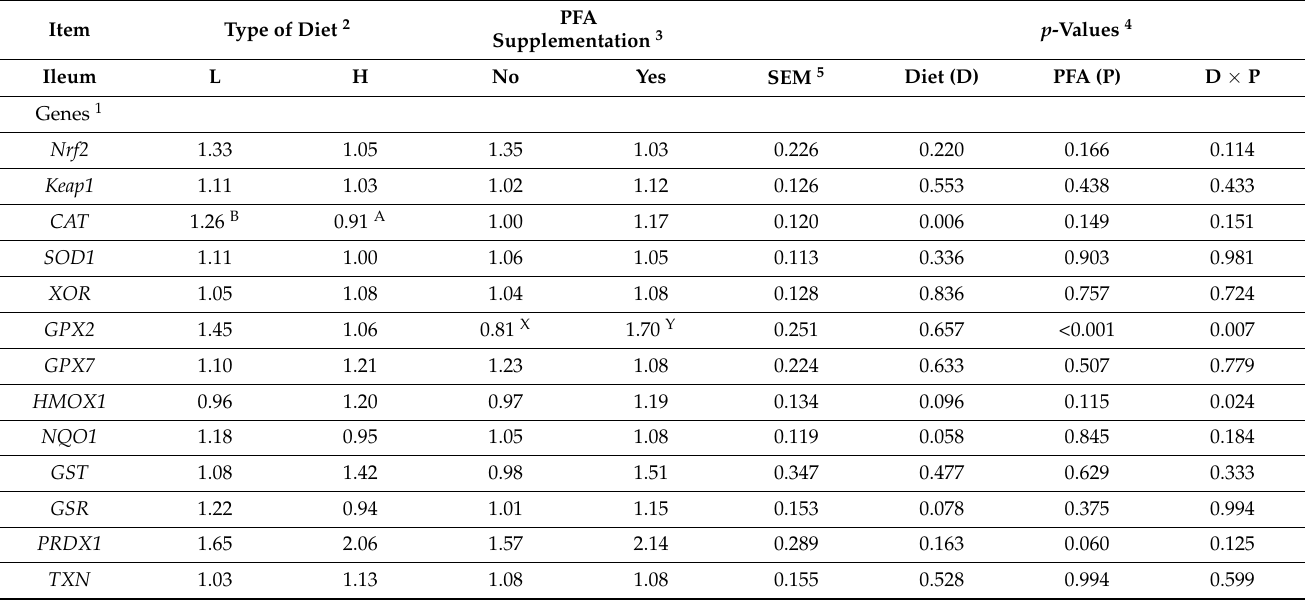
Table 5. Relative expression of the Nrf2 /ARE pathway genes in the ileal mucosa of 42-day-old broilers.